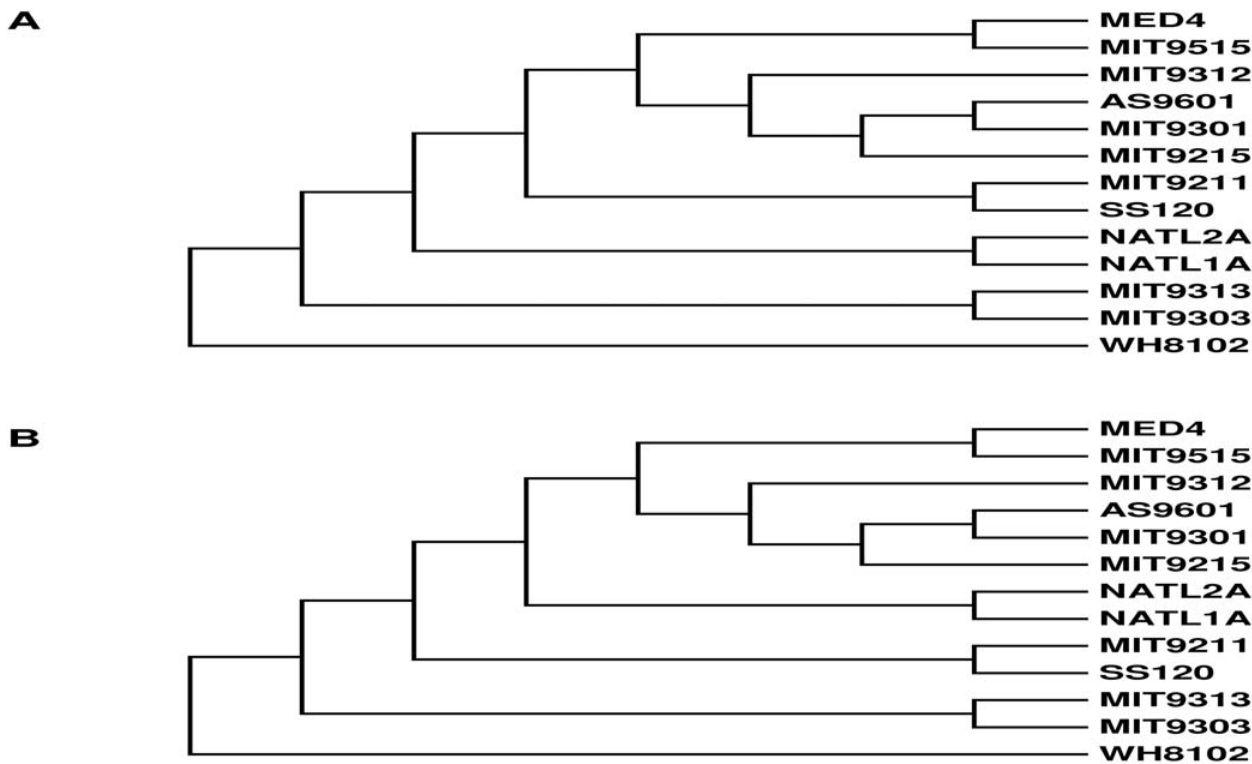
Figure 3. Proposed phylogeny of 12 Prochlorococcus genomes by integrating gene order phylogeny as well as phylogeny inferred from random concatenation of 100 core genes. (A) MIT9211/SS120 clade is closer to the HL species (B) NATL1A/NATL2A clade is closer to the HL species.